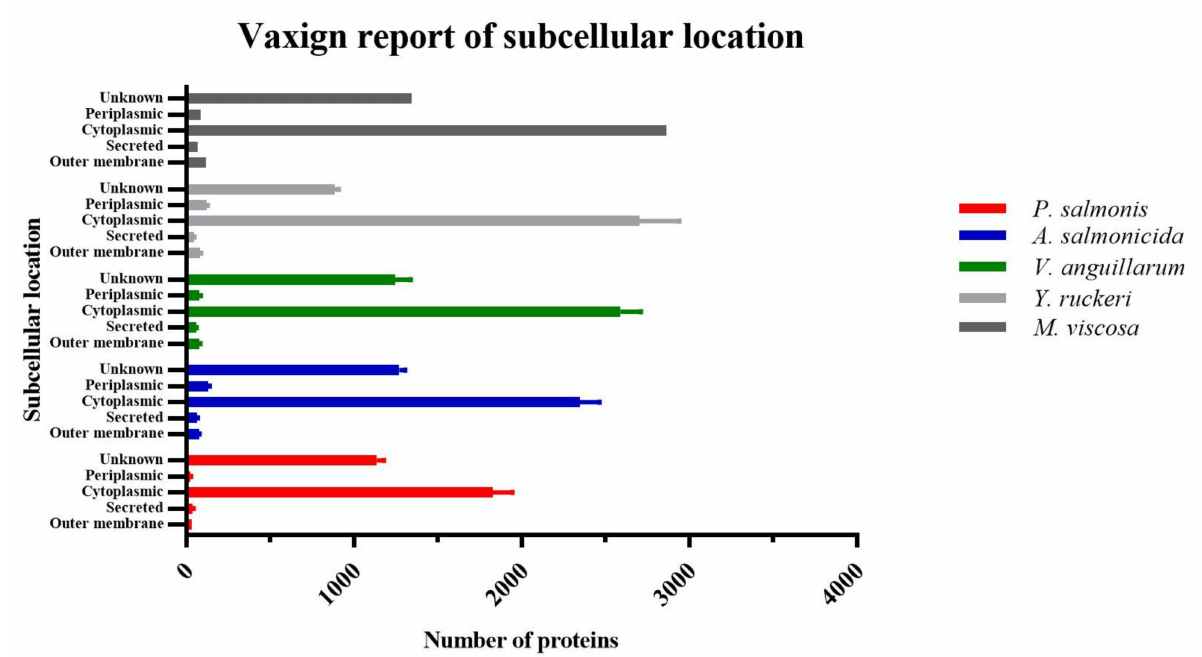
Figure 2. Vaxign report on subcellular localization of antigens discovered in all proteomes analyzed (Table 1). Moritella viscosa has no standard deviation (SD)bar because only one proteome was available for this